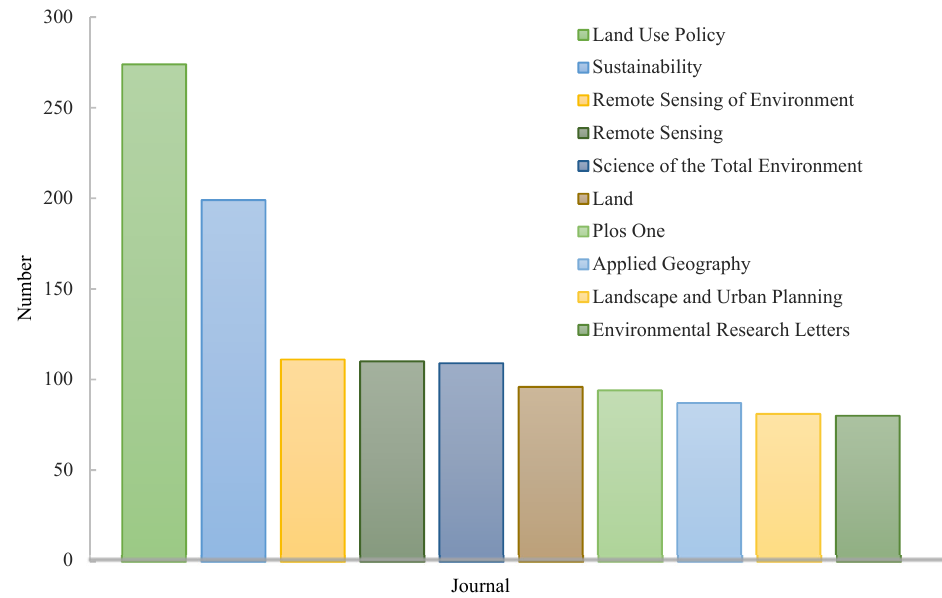
Figure 2. The top 10 journals with publication number concerning LUT during 1987–2020.